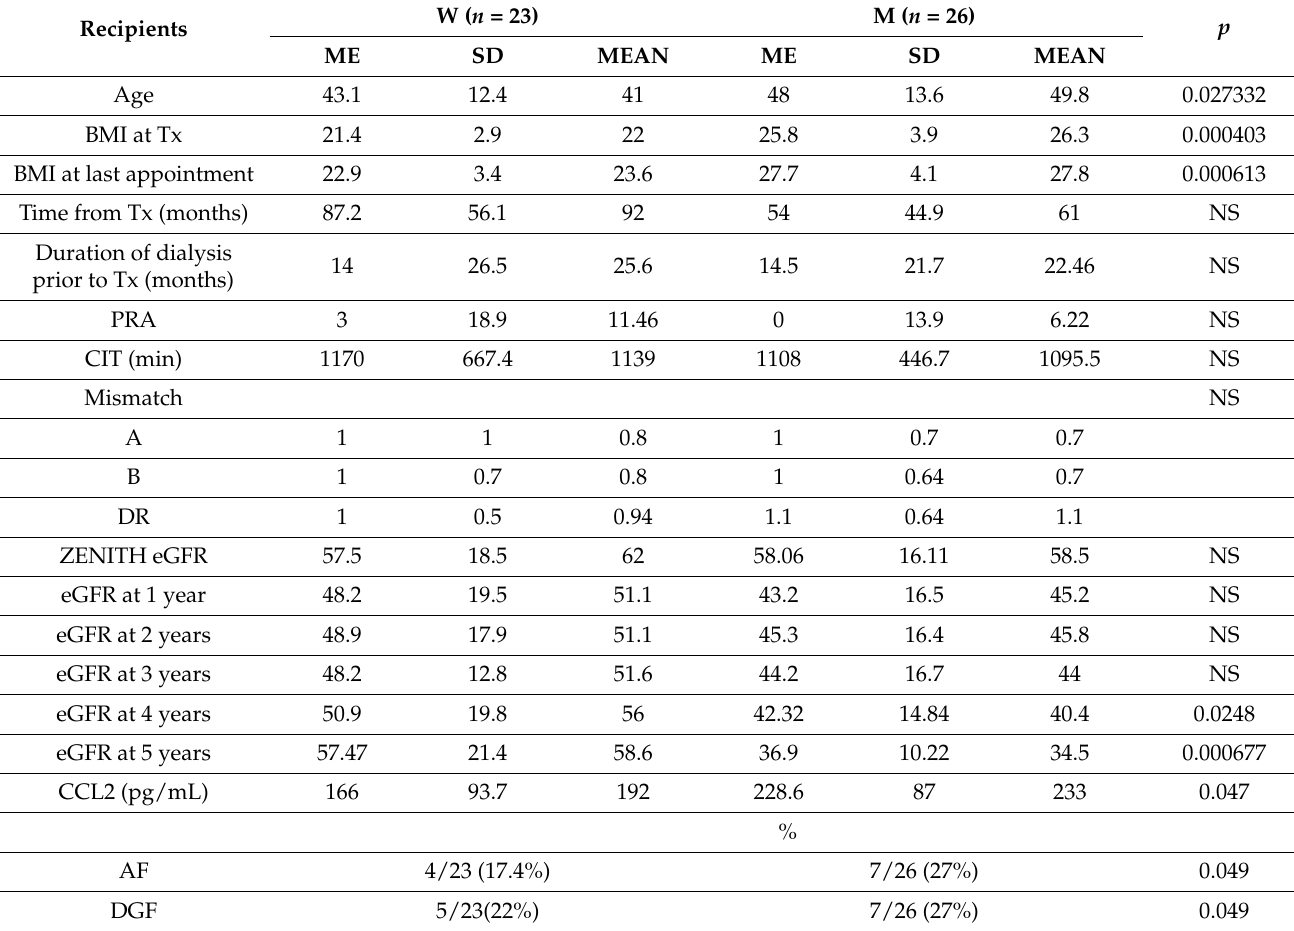
Table 1. Clinical characteristics of the female (W) and male (M) groups.